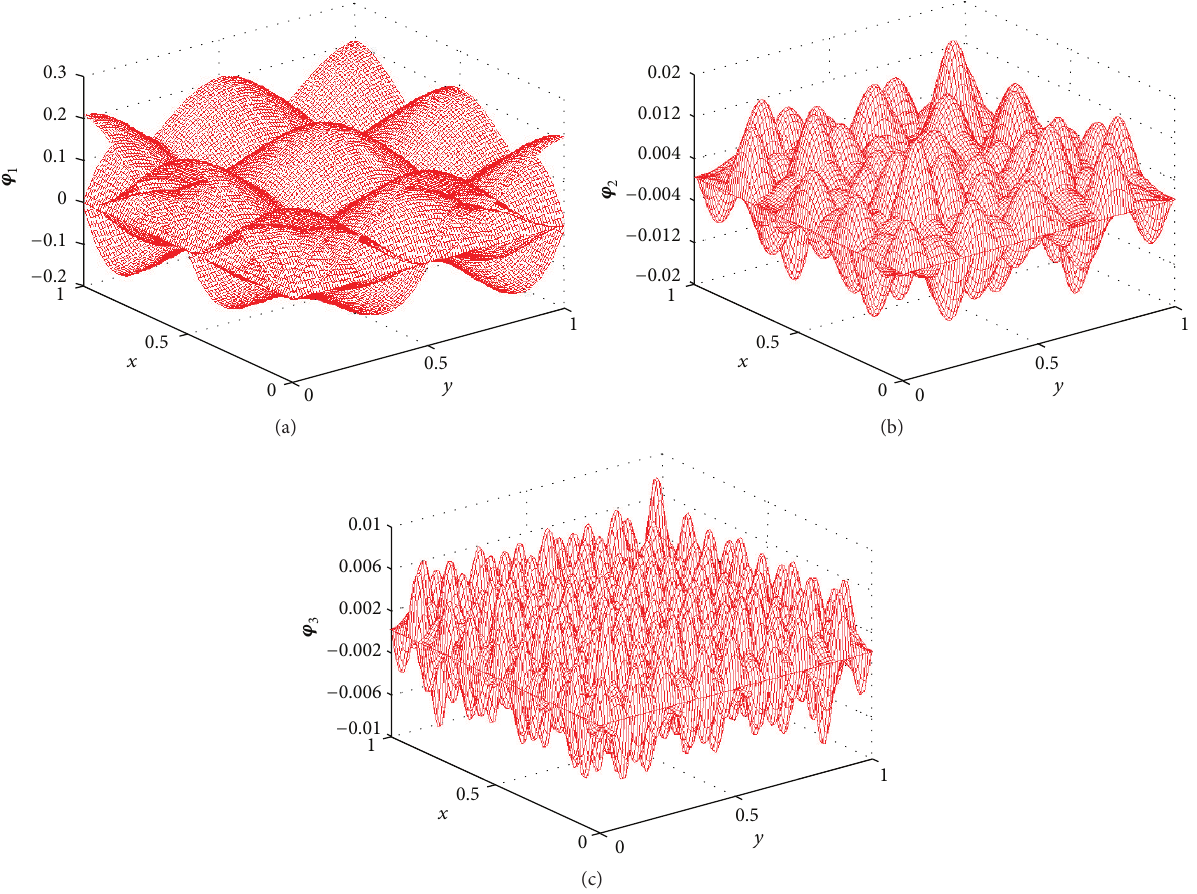
Figure 4: Tensor product HCSWI interpolation function: (a) modified scaling functions in scaling space 𝑉 1 ; (b) wavelet in wavelet space 𝑊 1 ; (c) wavelet in wavelet space 𝑊 2